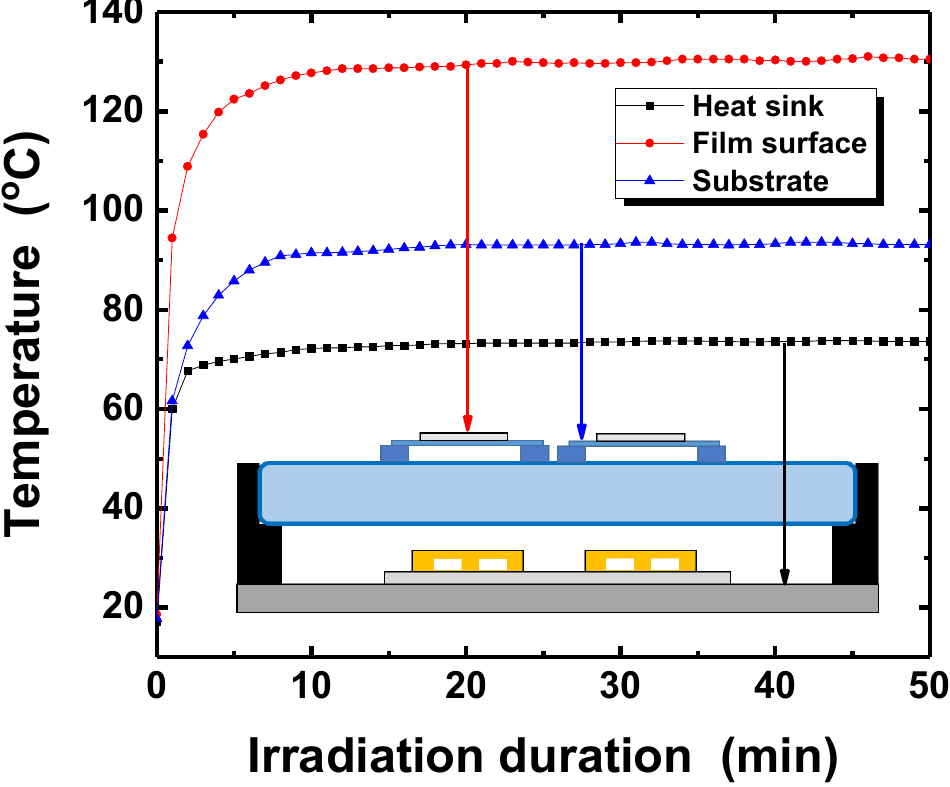
Figure 11. Temperature profiles of the silver film surface, the substrate, and the heat sink as a function of the irradiation duration. The light intensity of UV-LED module with the wavelength of 365 nm was 300 mW/cm 2 .